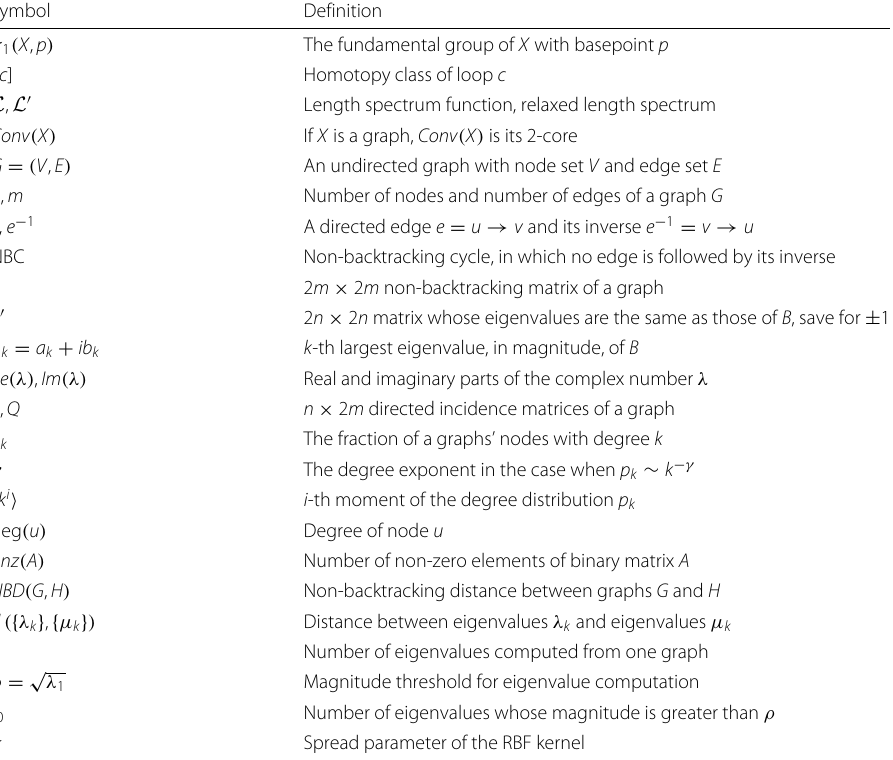
Table 1 Notation used in this